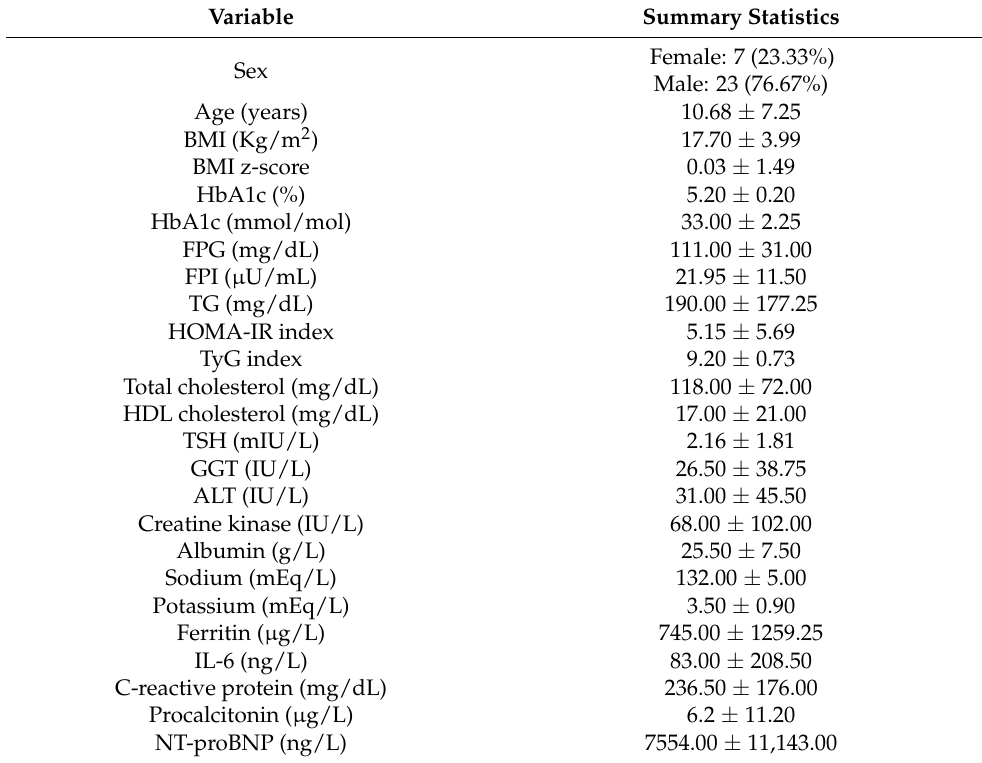
Table 1. Study participants’ characteristics at baseline. Summary statistics are presented as frequency (percentage) or median ± interquartile range.